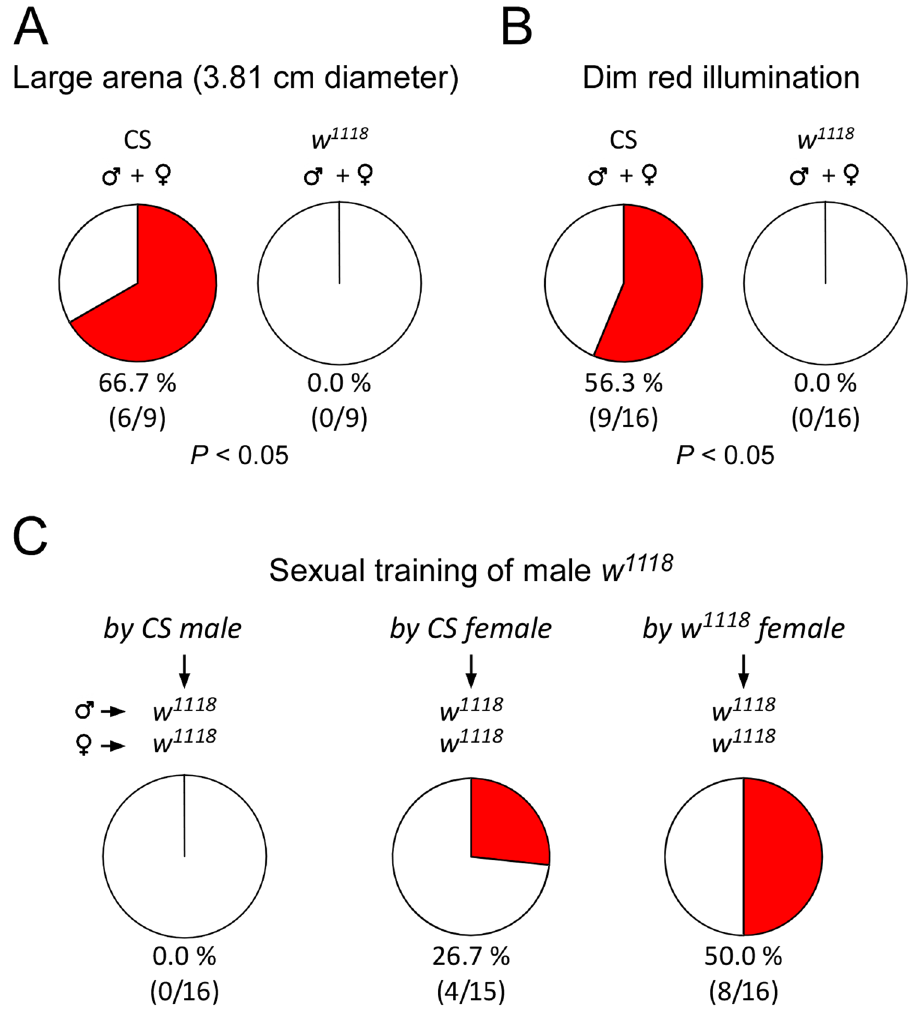
Figure 6. Male-female sexual experience promoted copulation success in w 1118 flies. ( A ) Copulation success (red) of CS and w 1118 flies in large arenas (3.81 cm diameter 0.3 cm depth). P value is from Fisher’s exact test. ( B ) Copulation success of CS and w 1118 flies under dim red illumination. P value is from Fisher’s exact test. ( C ) Copulation success between sexually trained w 1118 males and w 1118 virgin females. Training conditions are indicated (see Methods for